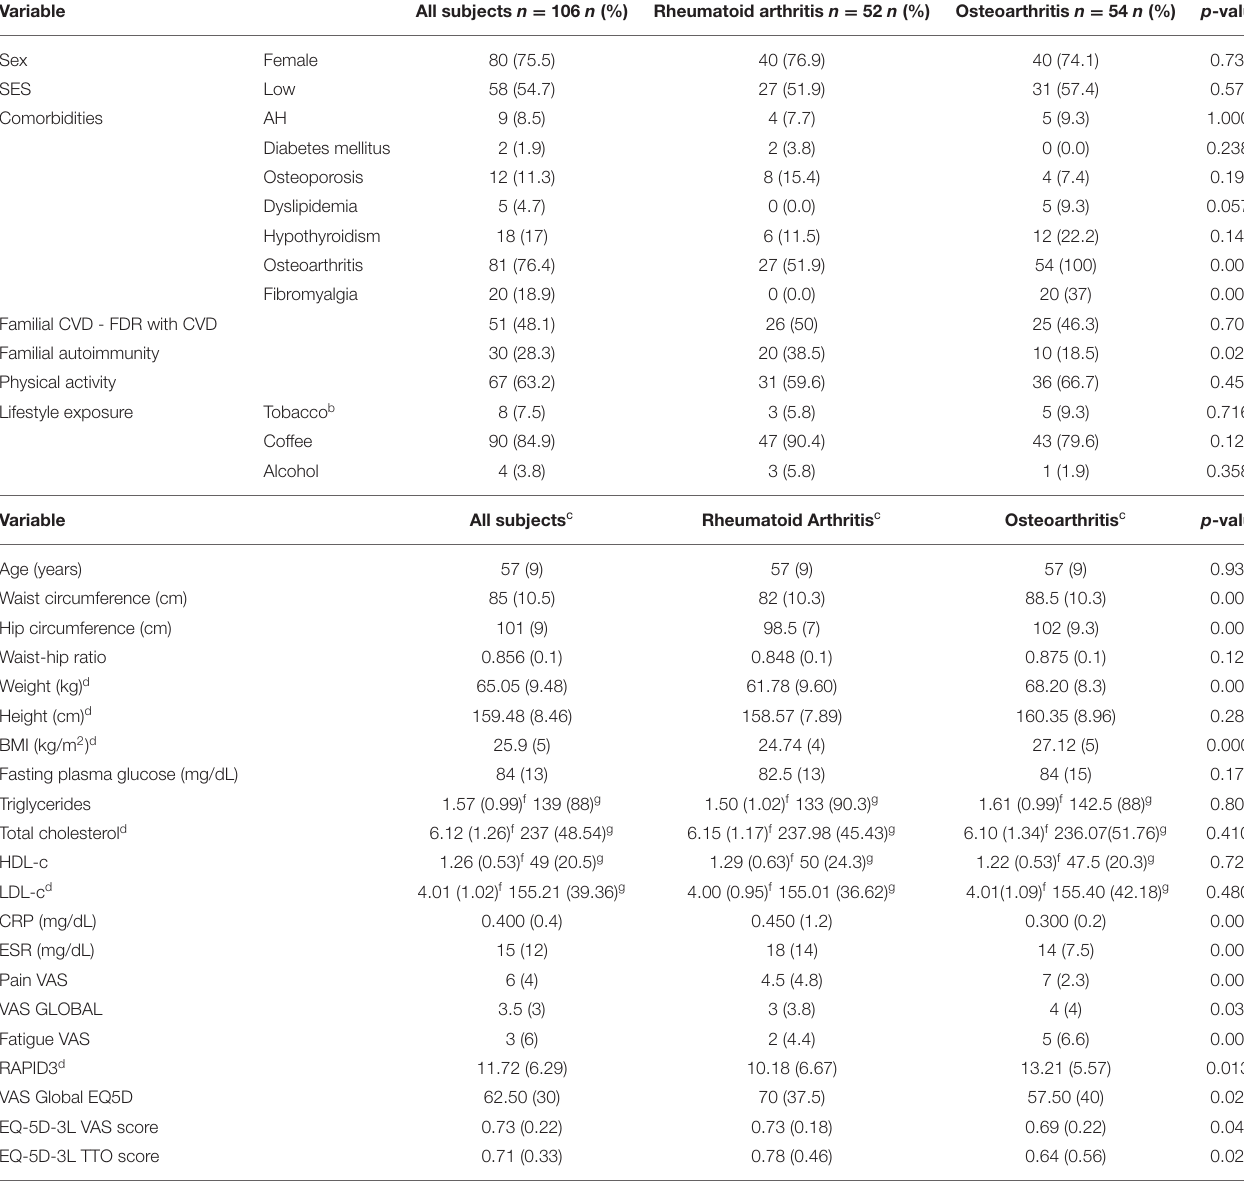
TABLE 1 | General